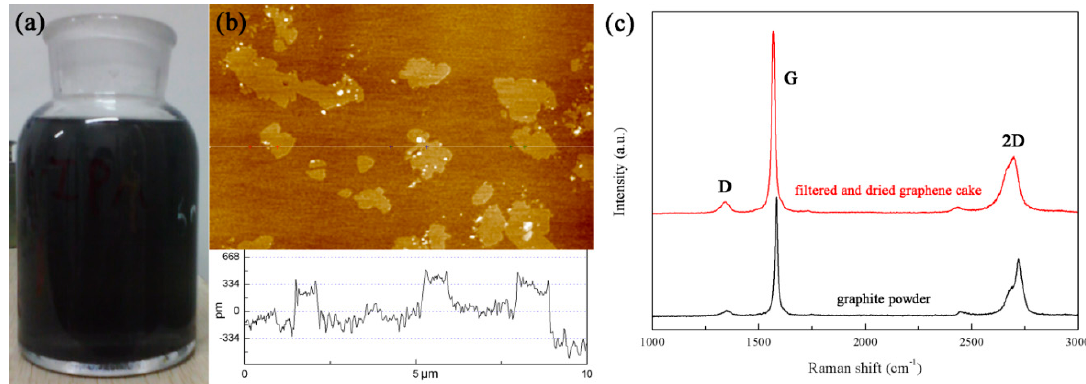
Figure 4. ( a ) photograph of graphene dispersion; ( b ) AFM image of grapheme; ( c ) Raman spectra of a dried graphene cake and pristine graphite powder.